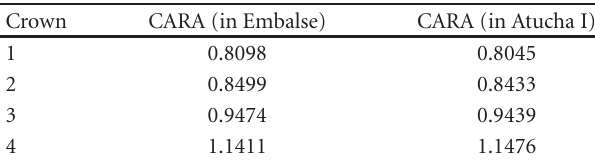
Figure 19: Local temperature in the 7th segment of a fuel rod of the Atucha I NPP and a CARA fuel at the 7th axial position in the channel. Table 15: WIMS results for the CARA rod power distribution for 0.9% SEU at